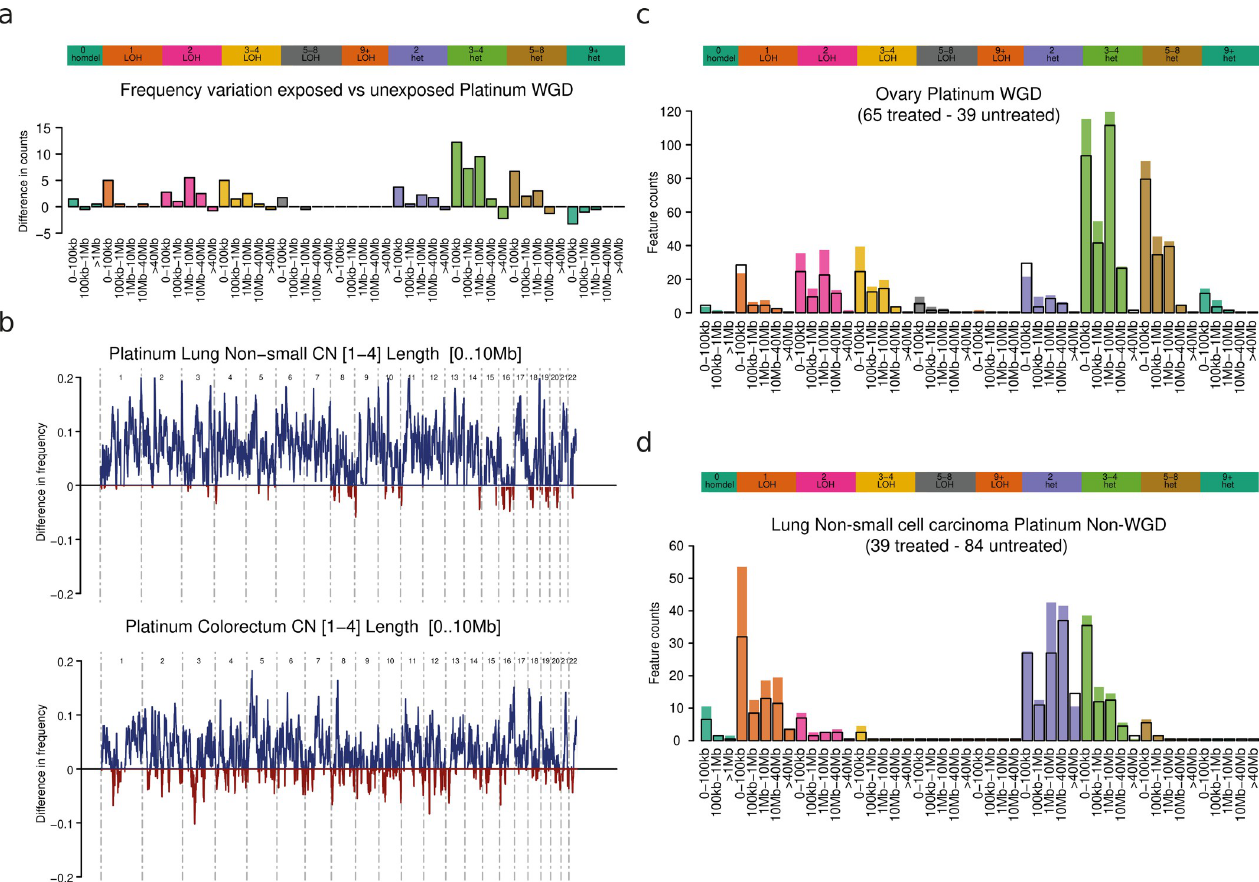
Fig 3. CN footprint of platinum-based therapies. a) Representation of the CN footprint of platinum based therapies. The bars represent the average (across WGD lung and colorectal tumors) number of chromosomal fragments in each CN category. b) Frequency of occurrence of chromosomal fragments with copy number 1–4 and length smaller than between 10 Kb and 10 Mb across WGD lung (left) and colorectal (right) tumors in the HMF cohort of tumors exposed (blue, positive) or unexposed (red, negative) to platinum-based drugs. c) Results of the comparison of CN categories across WGD ovarian tumors exposed or unexposed to platinum-based drugs in the HMF cohort. d) Results of the comparison of CN categories across non-WGD lung tumors exposed or unexposed to platinum-based drugs in the HMF cohort.